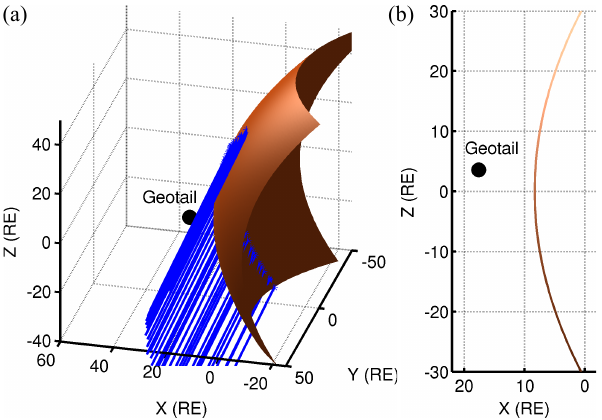
Figure 10. (a) Plot showing the location of Geotail at 08:16:10UT on 30 August 2004 with respect to the bow shock following the model by Merka et al. (2005) and the foreshock edge assuming that the maximum θ B − n for ion reflection is 60 ◦ and the reflected ions have twice the solar wind speed (in the solar wind frame). (b) x – z slice at the y coordinate of Geotail showing the spacecraft and the bow shock location. (Plots in GSE